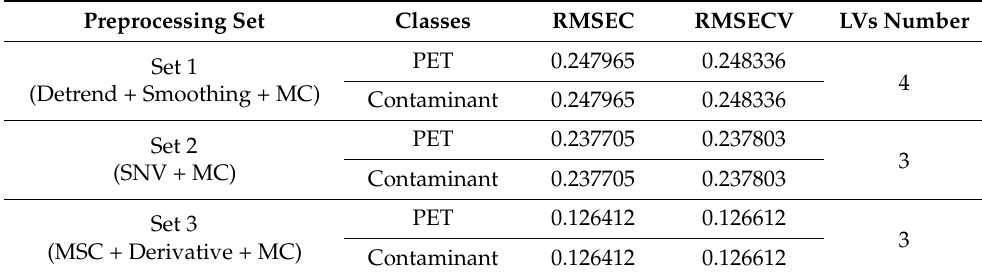
Figure 7. PCA results for preprocessing Set 3 (MSC + Derivative + MC): PCA score plot (PC1-PC2) ( a ) and loadings plot of PC1 and PC2 related to PET and contaminant classes ( b ). Table 3. Root mean square error for calibration (RMSEC) and cross-validation (RMSECV) for the three PLS-DA models constructed for preprocessing Set 1, 2, and